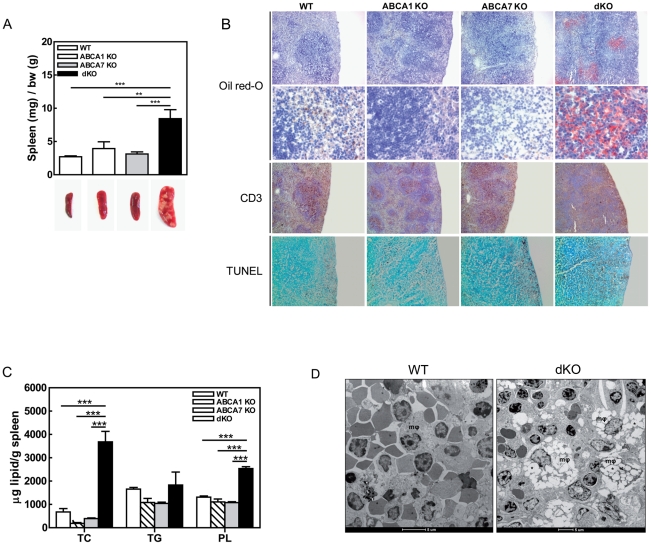
Effects of single macrophage ABCA7 and combined macrophage ABCA1 and ABCA7 deficiency on spleen.(A) Relative spleen weights of transplanted mice to body weight (bw) and representative images are shown. (B) Cryosections of spleens from all groups of mice were stained for lipid accumulation using Oil-red O staining (original magnification ×50 for first row and ×400 for second row), against lymphocyte CD3 antigen by immunohistochemistry (original magnification ×40) and for apoptosis using TUNEL staining (original magnification ×40). (C) Lipids were extracted from spleens with organic solvents. Values represent the mean±SEM of ≥9 mice per group. Statistically significant difference **p<0.01 and ***p<0.001. (D) Electron microscopic images of spleens from WT and dKO mice. Macrophages (mφ) of dKO transplanted mice exhibited massive cytoplasmic lipid accumulation (*).